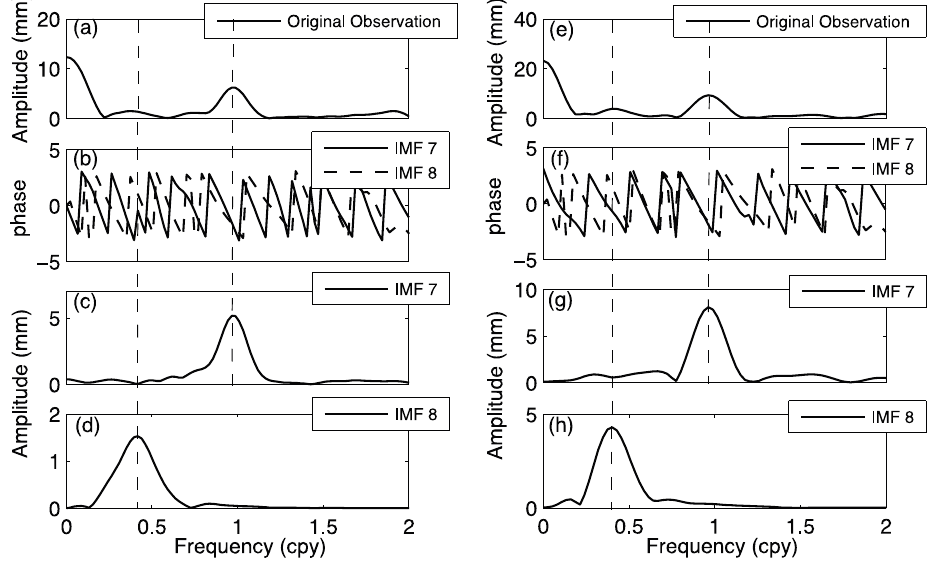
Figure 5. ( a – d ) The decomposed signals at LHAZ and ( e – h ) at KUNM GPS stations as IMF7 and IMF8 correspondent their phases; ( a , e ) are the spectrum of original GPS time series; ( b , f ) are the phase of annual and quasi-biennial signals; ( c , g ) are amplitude spectrum of annual signal; ( d , h ) are amplitude spectrum of quasi-biennial